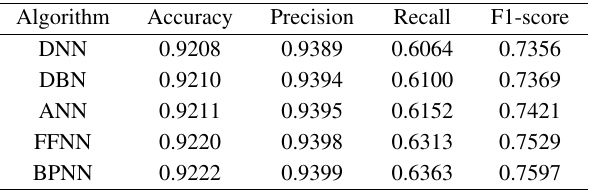
Table 2 Performance of ketoamide drug interaction with SARS-CoV-2 virus over Indian datasets.